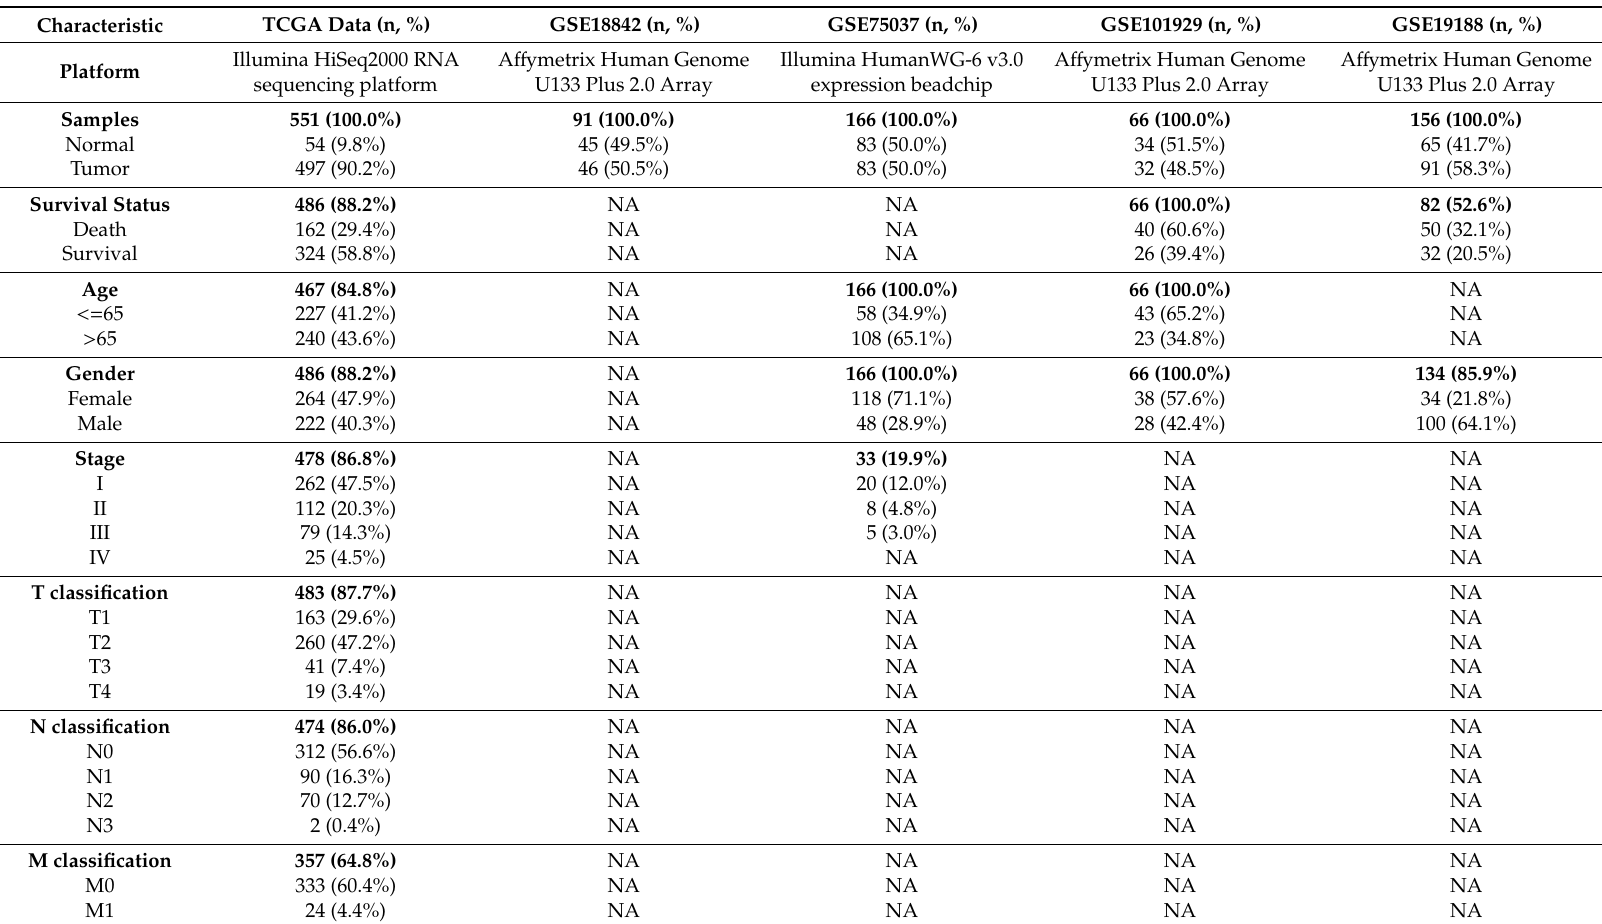
Table 1. Clinical characteristics of patients with lung cancer in di ff erent